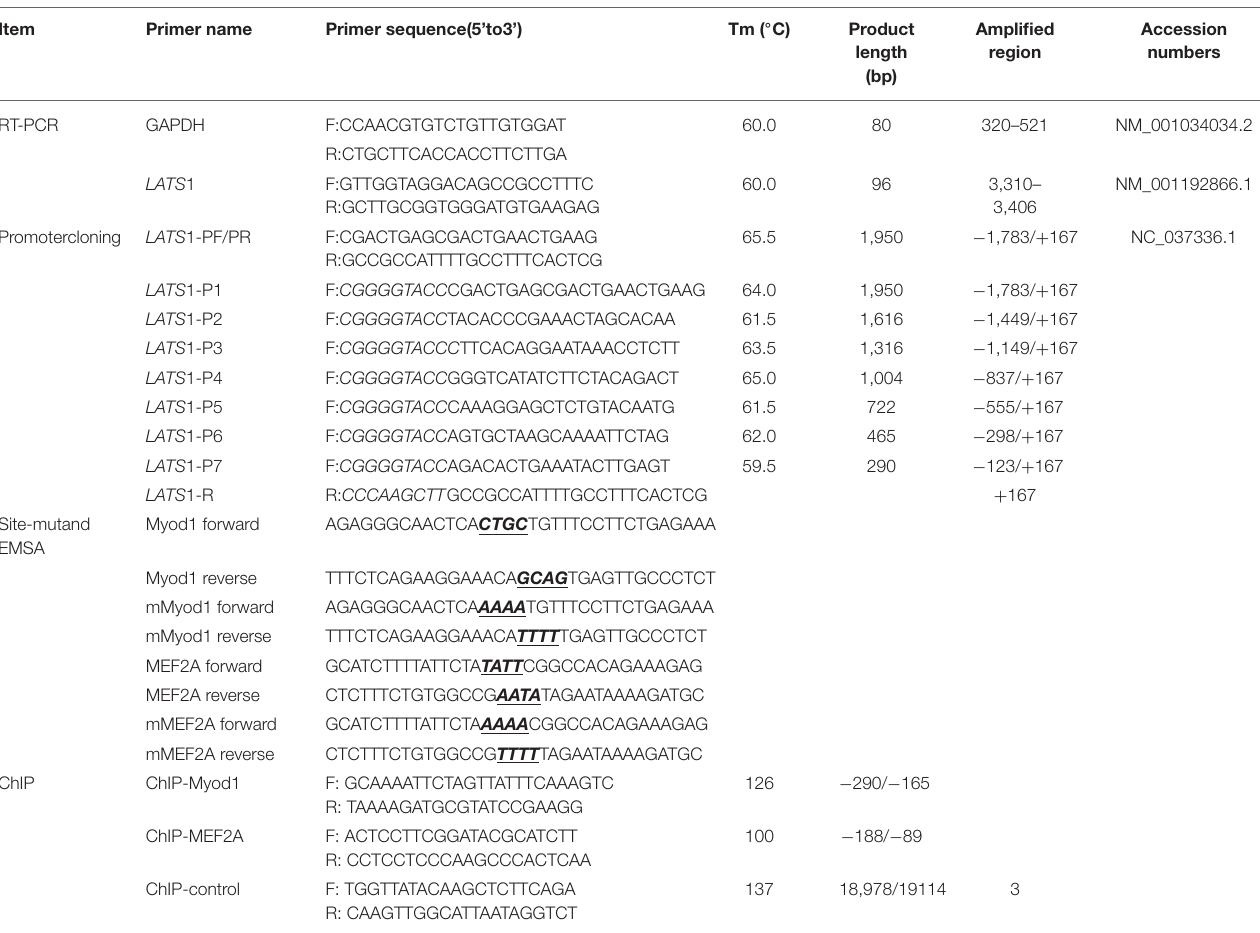
TABLE 1 | Primers utilized in this